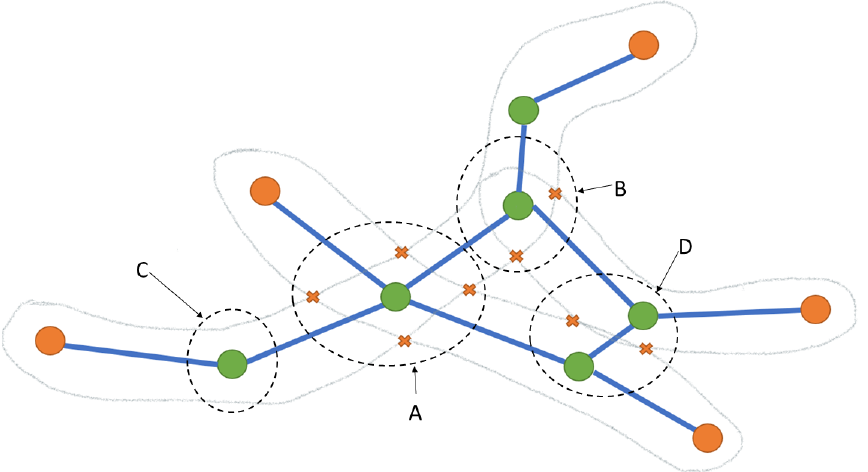
Figure 5. An example of graph representation of over segmented bacterial images. The edges represent the skeleton connections; the blue vertices represent branching points ( bp ) of the skeleton, the orange points represent the endpoints ( ep ), and the cross points represent the extracted concave points ( cp ). Here, “A” represents an instance of X -type, “B” represents an instance of Y -type, “C” represents an instance of I -type, and “D” represents an instance of H